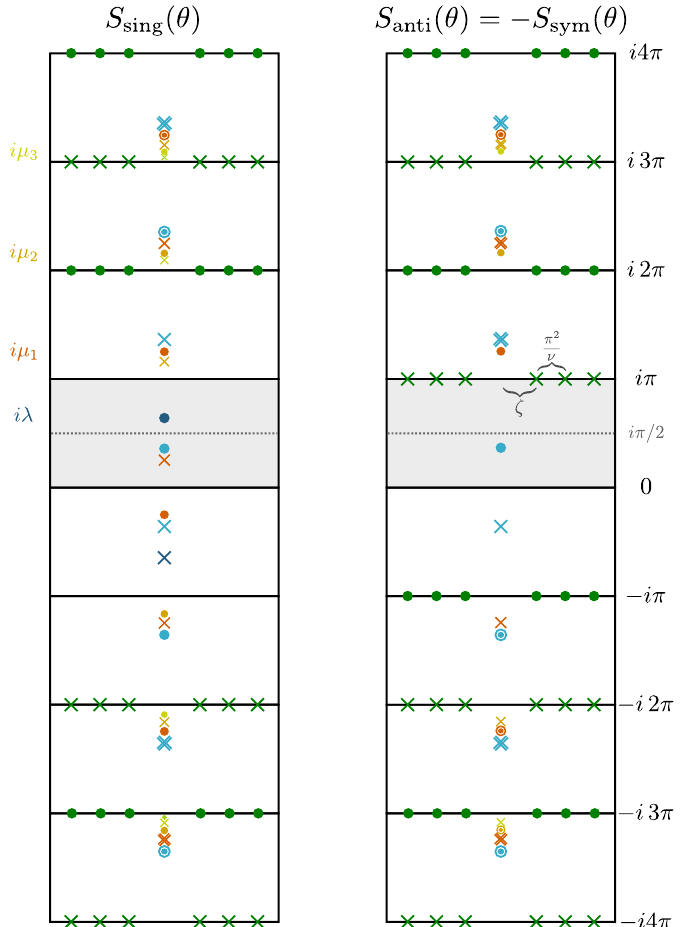
Figure 16 . Analytic structure of the solution to the maximization of g sing with no other bound states given in (4.22). The anti-symmetric and symmetric representations are the same up to a minus sign. The double crosses and circles represent double zeros and poles, respectively. The parameters (cid:22) i specify the position of the new zeros and poles appearing in the singlet representation. The (cid:12)rst zeroes at the upper boundary of the physical strip depicted in green are located at (cid:18) = i(cid:25) (cid:6) (cid:16) and the rest are spaced by multiples of (cid:25) 2 =(cid:23)